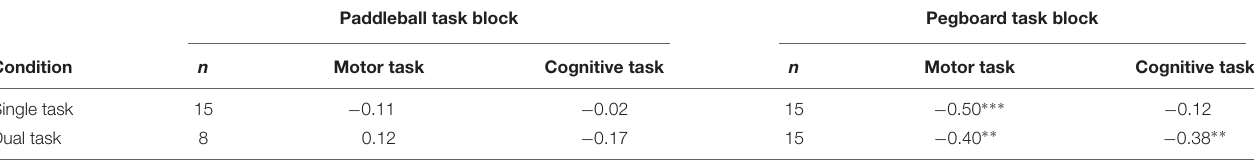
TABLE 1 | Correlations between cortical load and measures of cognitive and motor performance. Paddleball task